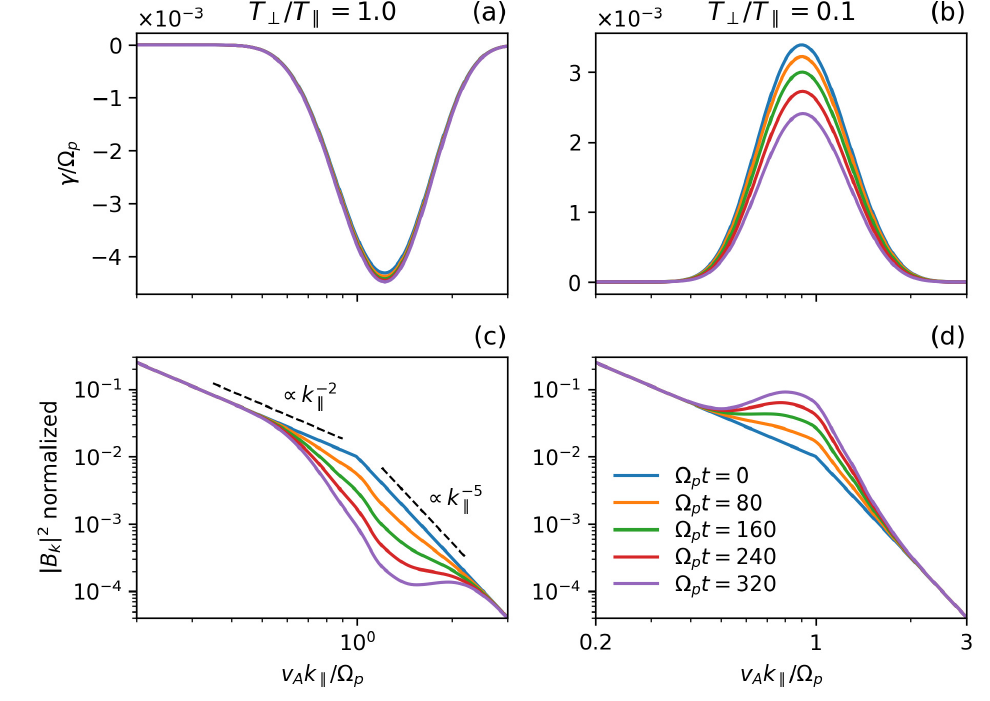
Figure 1. Time evolution of ( a , b ) the growth/damping rate γ / Ω p of magnetosonic waves, and Lv A / Ω p ), both as a function of the normal- ( c , d ) the magnetic wave spectrum | B k | 2 (normalized to B 2 0 ized wavenumber v A k (cid:107) / Ω p . Initial conditions are β (cid:107) ( 0 ) = 1.1, W B ( 0 ) = 2.0 for a magnetic spectrum with α = 5, and ( a , c ) T ⊥ / T (cid:107) ( 0 ) = 1, and ( b , d ) T ⊥ / T (cid:107) ( 0 ) = 0.1. The axes showing wavenumber and magnetic power are in